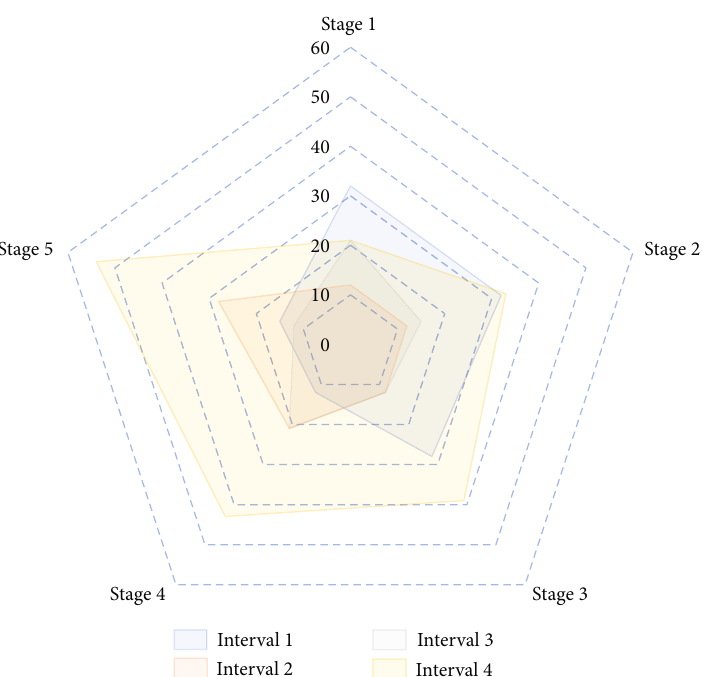
Figure 2: Video monitoring pro fi le mapping level set